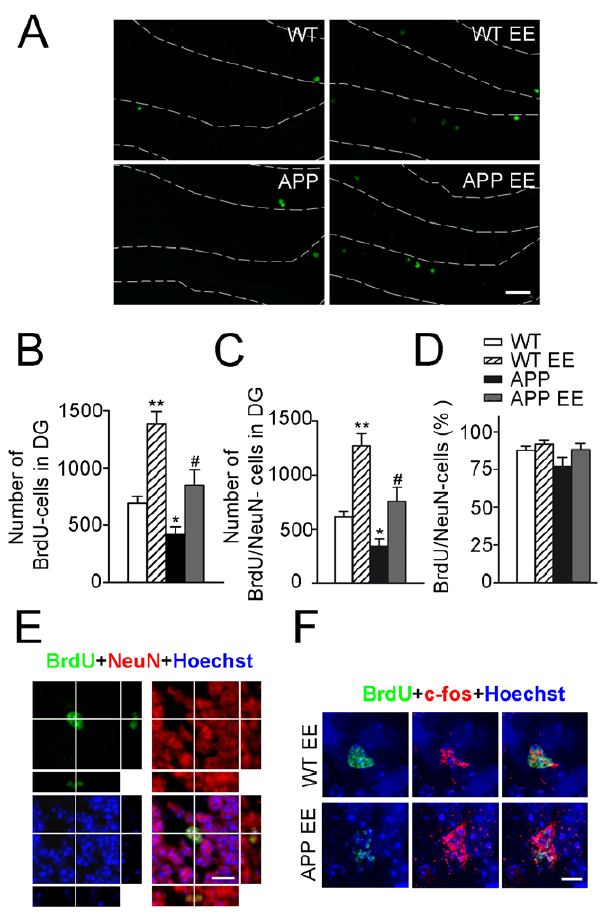
Figure 2. Environmental enrichment increases adult neurogen- esis in APP Sw,Ind mice. (A) Confocal microscopy images showing BrdU (green) positive cells in the granule cell layer (GCL; dashed lines). Scale bar =40 m m. (B) Neurogenesis was assessed by counting the number of BrdU-stained cells in one of six sections throughout the whole rostro-caudal axis of the DG and estimating the total number of BrdU cells according to the DG volume. Total number of BrdU cells is significantly decreased in the DG of APP Sw,Ind mice whereas environ- mental enrichment (EE) increases significantly the number of BrdU cells in APP Sw,Ind mice. (C) Total number of newly-generated neurons (BrdU/ NeuN cells) was significantly reduced in APP Sw,Ind mice and increased by EE. (D) No significant differences in the percentage of BrdU/NeuN-cells are detected among the experimental groups indicating that EE recovers normal levels of adult neurogenesis without altering the rate of neuronal differentiation in APP Sw,Ind mice. (E) Confocal microscopy images of the GCL of a WT mouse stained for BrdU (green), NeuN (red), and counterstained with Hoechst (blue). Lines intersect in a double stained cell and indicate orthogonal planes showed in the right (y-z axis) and bottom (x-z axis). Scale bar =10 m m. (F) Confocal microscopy images of the GCL of the dentate gyrus showing a single (WT EE) or two (APP EE) neurons triple stained for BrdU (green), c-fos (red) and Hoeschst (blue). Scale bar =5 m m. Data represent mean 6 SEM. *p , 0.05 and **p , 0.01, compared to WT mice. # p , 0.05 compared to APP Sw,Ind mice. Number of mice: WT (n=8), WT EE (n=7), APP Sw,Ind (n=6) and APP Sw,Ind EE (n=6).